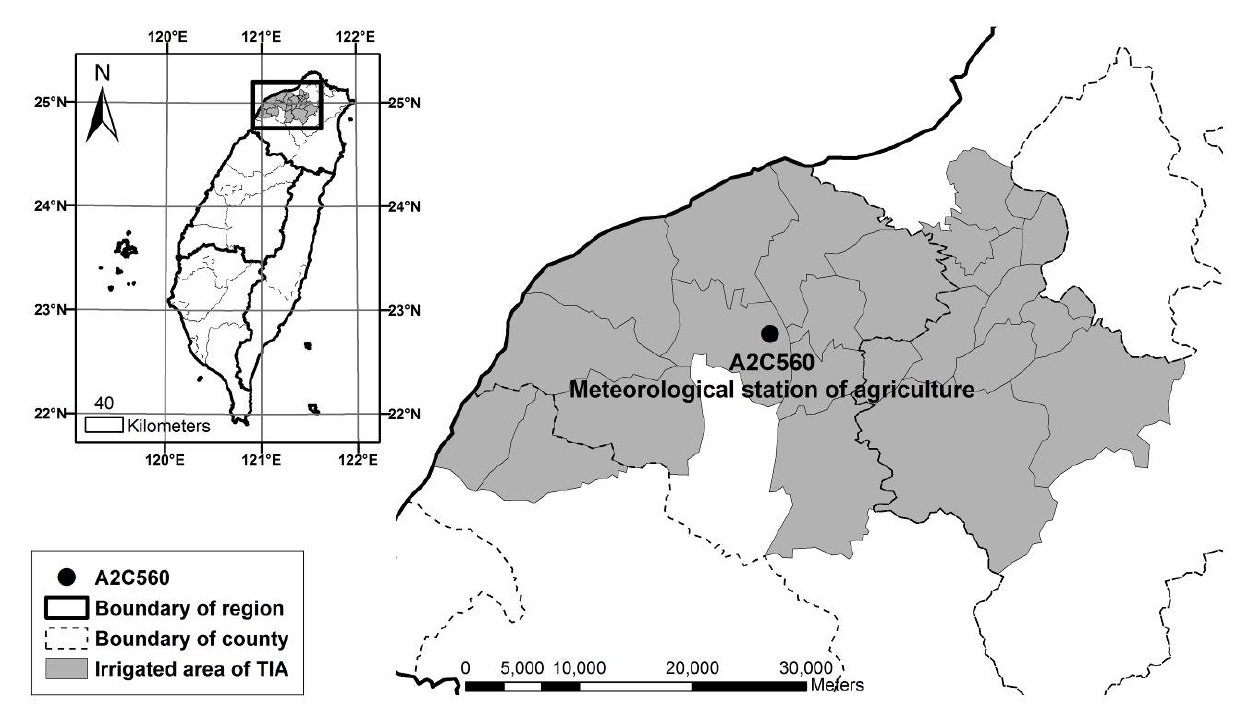
Figure 2. Location of study area and meteorological